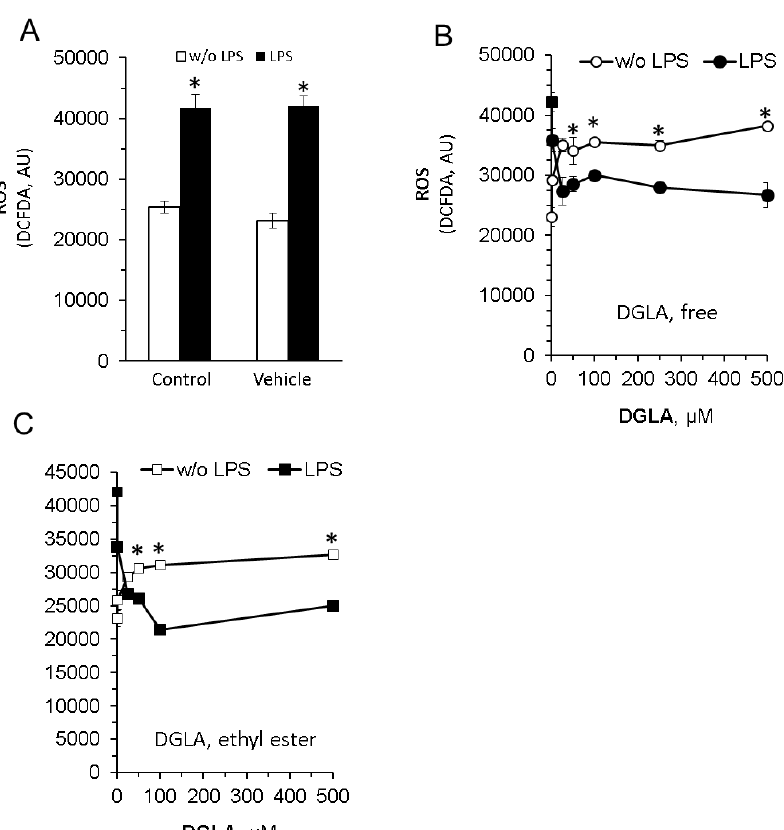
Figure 3. DGLA alters reactive oxygen species (ROS) production in RAW264.7 macrophages. Inflammation in the cells was induced by LPS (100 ng/mL). Concomitantly, the cells were treated without (w/o) or with increasing DGLA concentrations. After 24 h of incubation, cells were mounted with a fluorogenic dye 5-(and 6) -carboxy-2’ 7’-dichlorodihydrofluorescein diacetate (DC-FDA), and ROS levels were estimated by fluorescence measurements. ROS levels, enhanced by LPS ( A ) or modulated by DGLA administered as free acid or ethyl ester form ( B , C ), are presented. Data are presented as mean ± SD. * denotes a significant difference compared to respective control, p < 0.05, n = 3. Control—untreated cells; vehicle—cells treated with 0.1% DMSO, the solvent used in DGLA